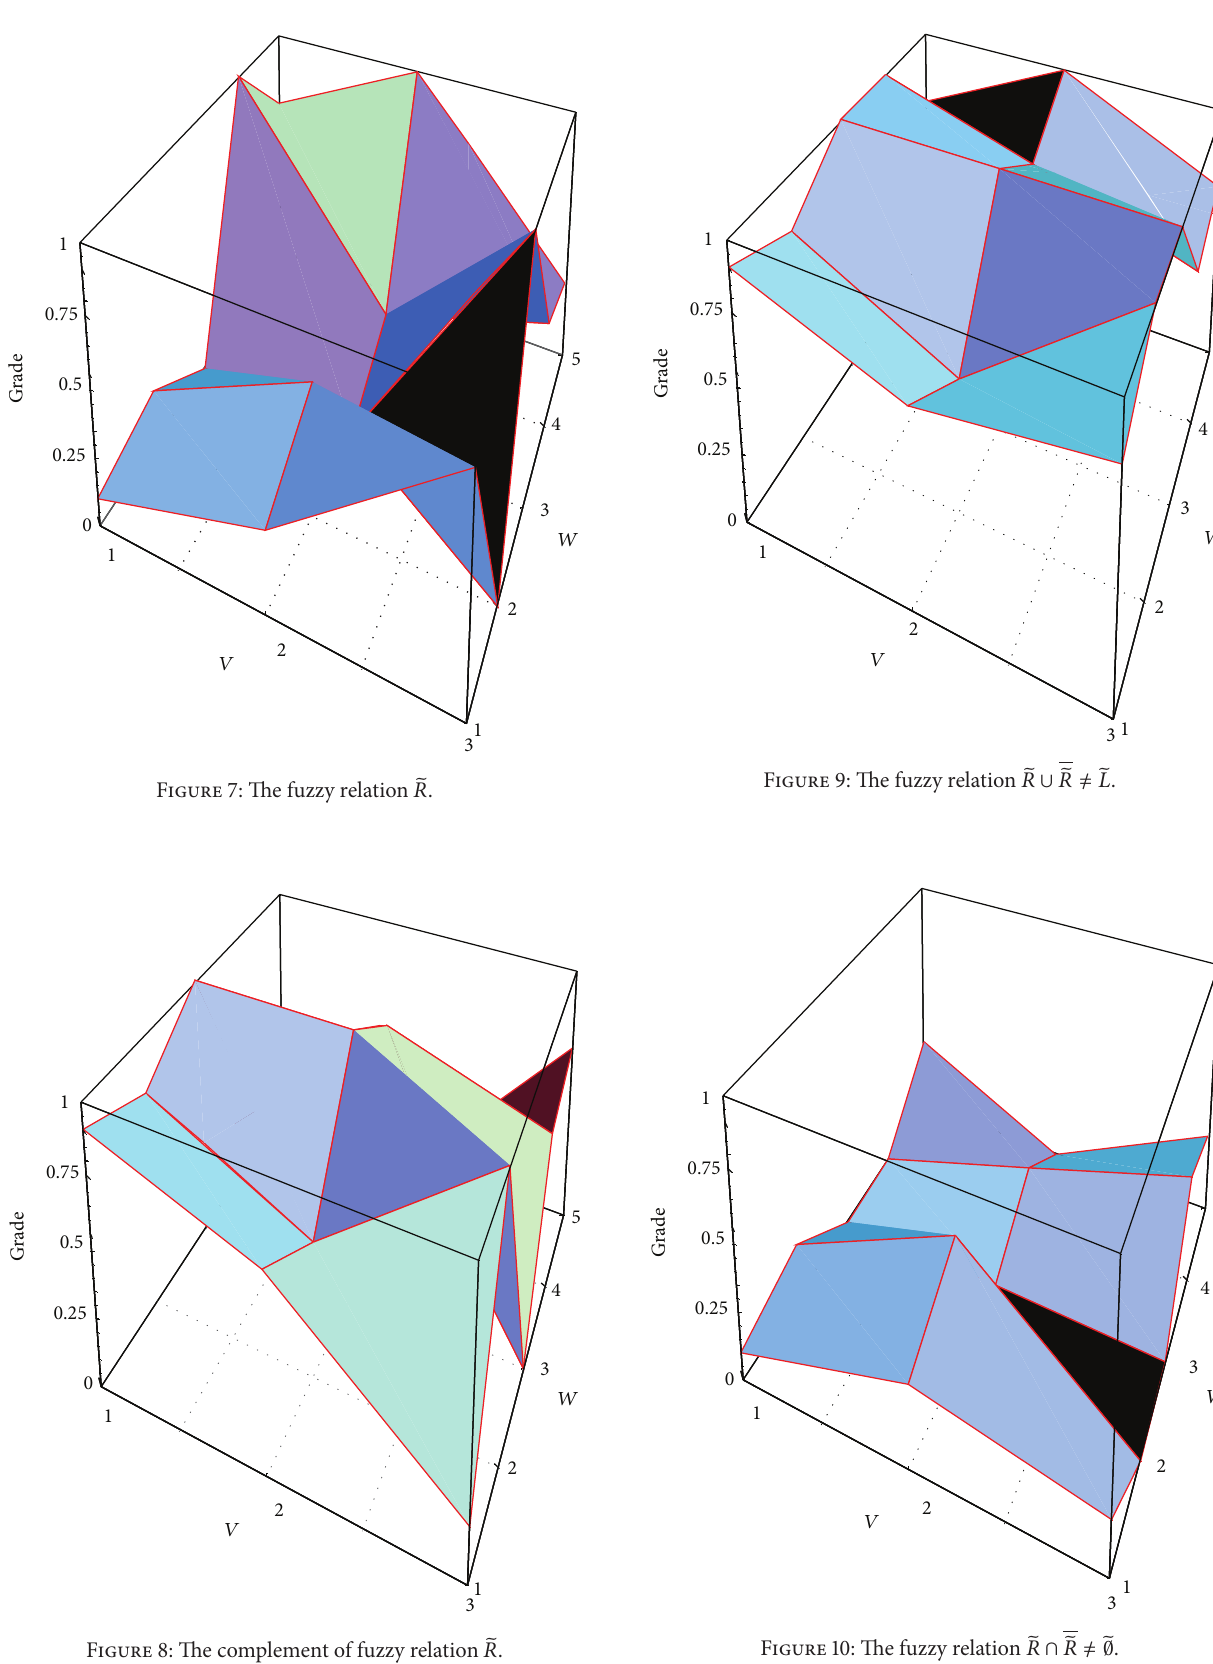
Figure 8: The complement of fuzzy relation